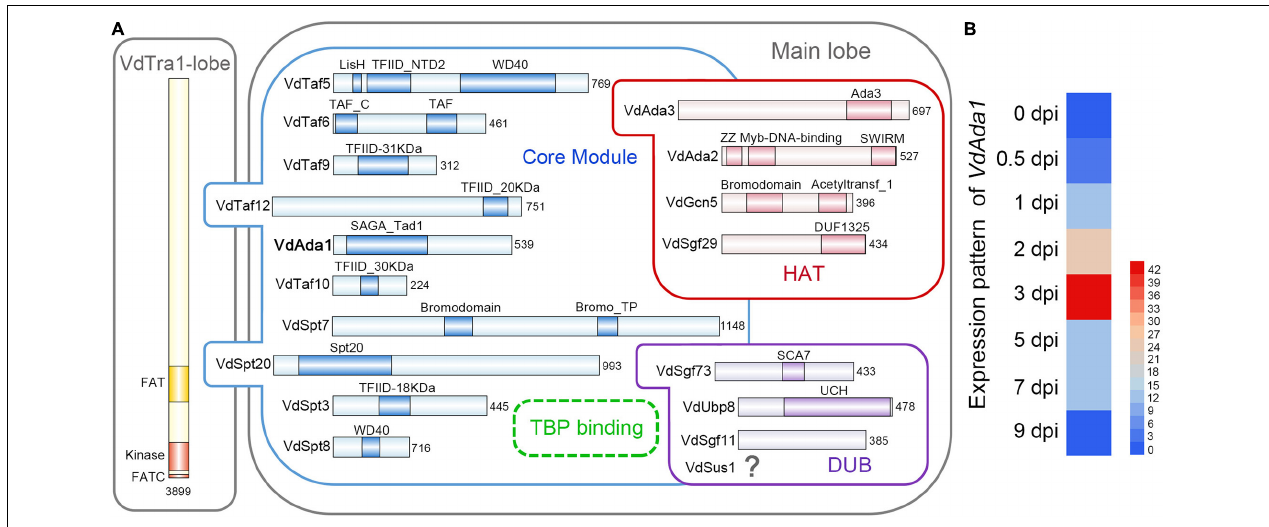
FIGURE 1 | Identification of the SAGA complex and Ada1 subunit in Verticillium dahliae . (A) Subunit and domain organization of the SAGA complex in V. dahliae . SAGA subunits are organized into the Tra1 lobe and the main lobe. The main lobe is divided into enzymatic HAT and DUB modules and a core module. The dotted circle near Spt3 and Spt8 indicates the TBP-binding site, where TBP is recruited. The numbers behind each subunit represent the number of amino acids. Figure design adapted from Cheon et al. (2020) and Papai et al. (2020) (B) Expression pattern analysis of VdAda1 . The level of VdAda1 transcription was detected by reverse transcription-quantitative PCR during colonization on cotton at 0, 0.5, 1, 2, 3, 5, and 7 days post-inoculation (dpi). The expression level of VdAda1 at 0 dpi was set to